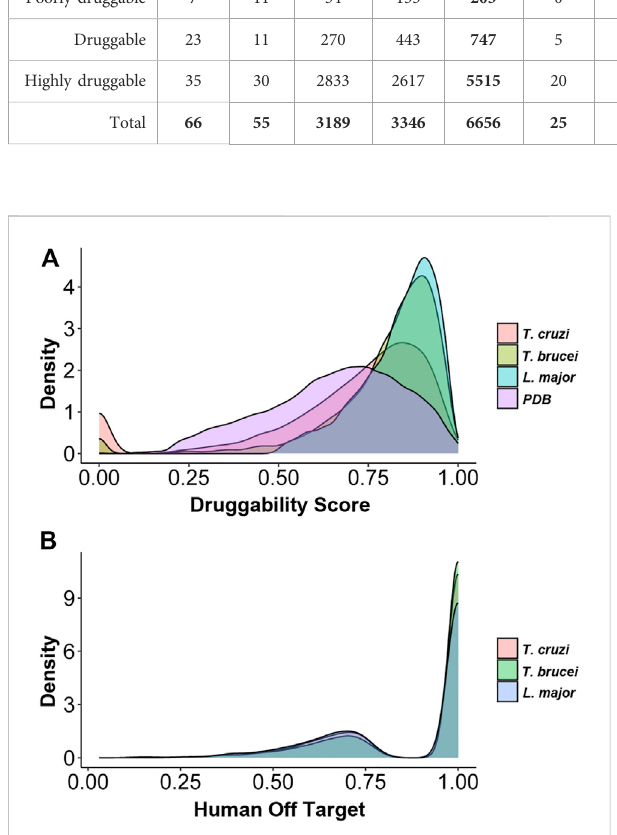
FIGURE 1 Distribution ofproteinDruggabilityScores ( DSs )and HumanOff- Target Scores ( HOT ) in each of the parasites (A) Density plots showing the distribution of DSs for Trypanosoma cruzi , Trypanosoma brucei , Leishmania major proteins as well as thecomplete PDB database for comparison (B) Density plots showing the distribution of HOT for Trypanosoma cruzi , Trypanosoma brucei and Leishmania major